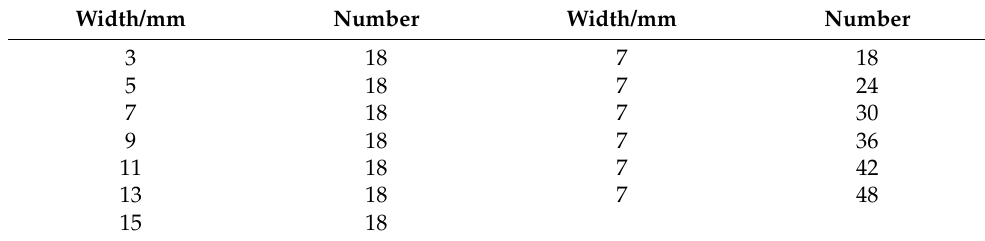
Table 2. Simulation scheme for retaining ring groove designs .